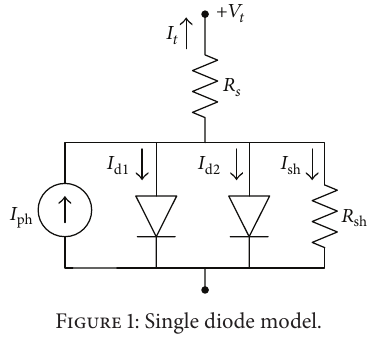
Figure 1: Single diode model.